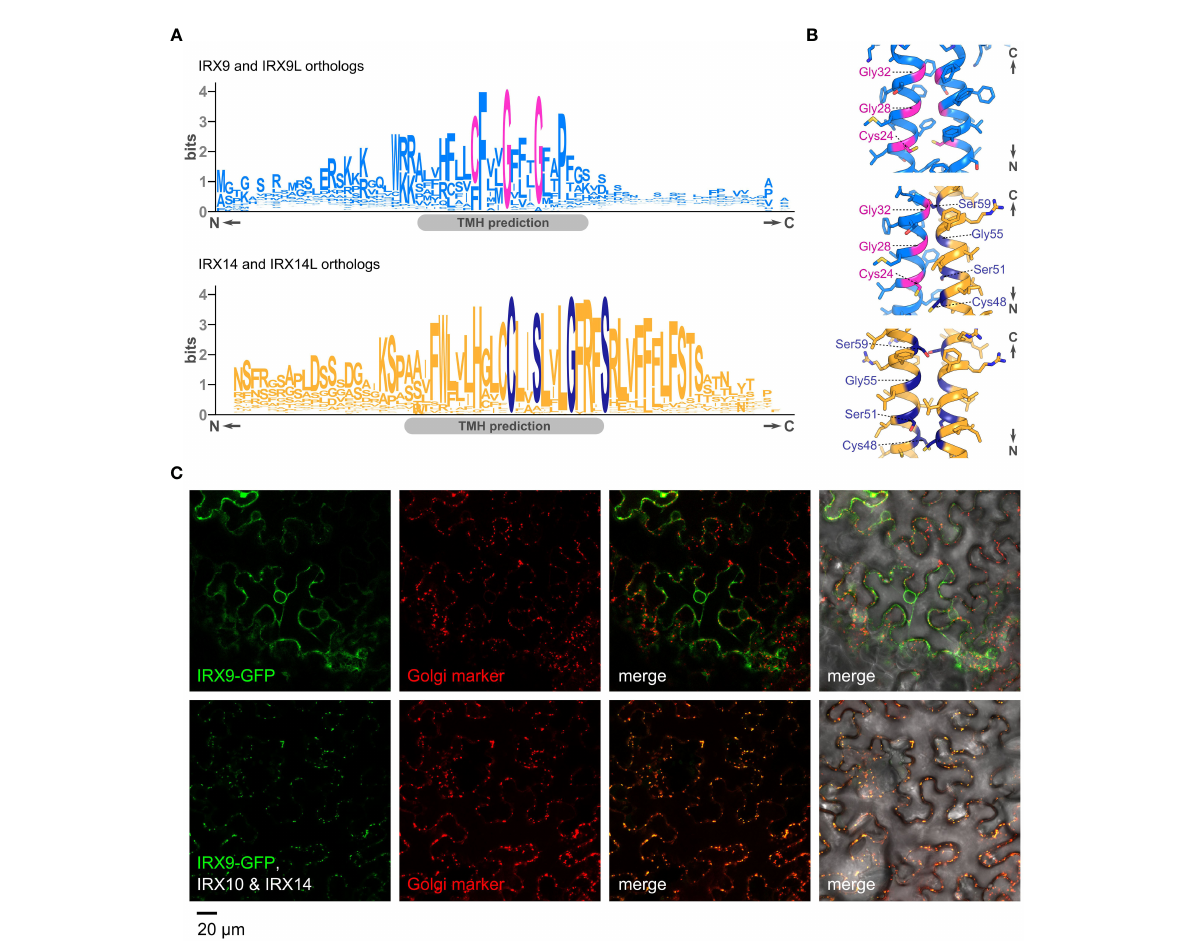
FIGURE 2 The CTS of GT43s, their potential interactions and impact of interactions on Golgi localization. (A) . Sequence logos showing conserved motifs in the predicted transmembrane helices (TMH) of orthologs of IRX9/IRX9L ( top ) and IRX14/IRX14L ( bottom ). (B) Close-ups of AlphaFold-Multimer models of the transmembrane dimers for an IRX9 homodimer ( top ), an IRX9 – IRX14 heterodimer ( middle ) and an IRX14 homodimer ( bottom ). Residues of the GAS right motif and conserved cysteines are highlighted in magenta or dark blue, respectively. (C) Subcellular localization of Arabidopsis IRX9-GFP, transiently expressed in tobacco leaves. Top panel ( left to right ), IRX9-GFP ( green ), ManI-mCherry from soy (Golgi marker, red ), merge of the two former, and merge including differential interference contrast (DIC) image. Bottom panel shows the same localization analysis in presence of co-expressed, untagged IRX10 and IRX14. Note the change of localization of IRX9-GFP in presence of IRX10 and